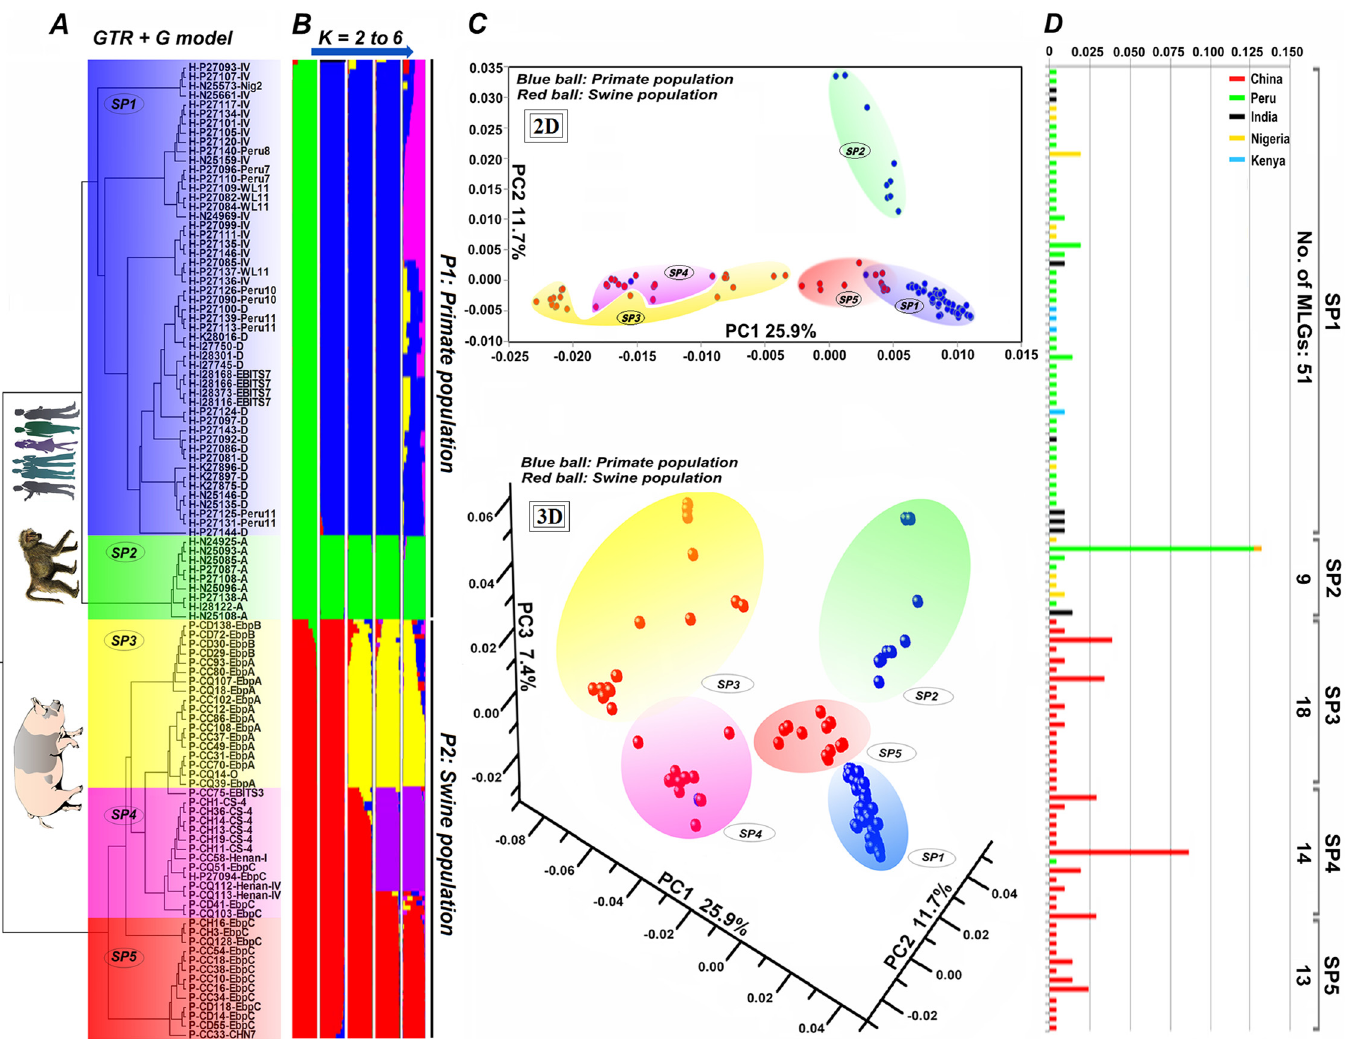
Fig 1. Comprehensive phylogenetic and structural analyses of Enterocytozoon bieneusi isolates from various hosts and locations. Panel A: Bayesian phylogenetic analysis of 105 unique multilocus genotypes (MLGs) from 207 isolates. Among them, 44 MLGs are from pigs, 61 from humans, and 4 from baboons, which are indicated by P, H, and B before the specimen numbers, respectively. The letters I, N, P, K, and C (C, D, H, and Q) followed indicate the isolates are from India, Nigeria, Peru, Kenya, and China (Changchun, Daqing, Harbin, and Qiqihar), respectively. ITS genotypes are labeled at the ends. Panel B: Subpopulation structure of all 207 E . bieneusi isolates. Various subpopulation patterns were obtained when different K values (2 to 6) were used. Panel C: Results of the principal coordinates analysis of 105 unique E . bieneusi MLGs based on pairwise distances. Red and blue balls represented the isolates from pig and primate populations, respectively. Panel D: Frequency (%) of E . bieneusi MLGs in the five subpopulations determined in structural